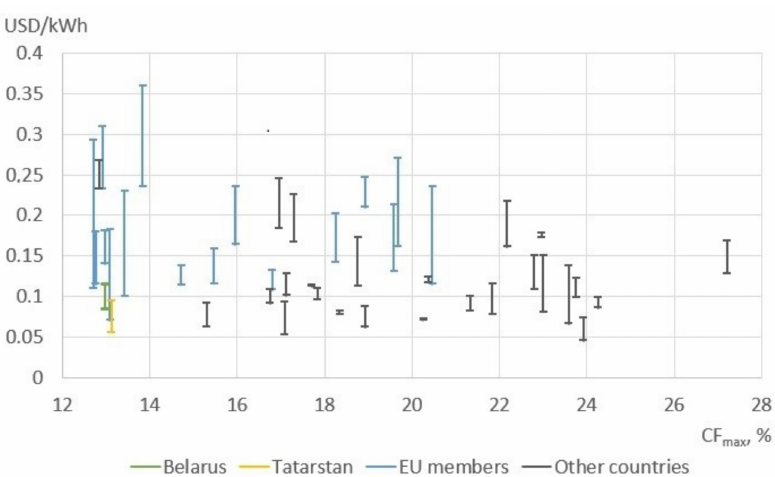
Figure 2. Comparison of Belarus and Tatarstan with leading countries by electricity price and maximum capacity factor of